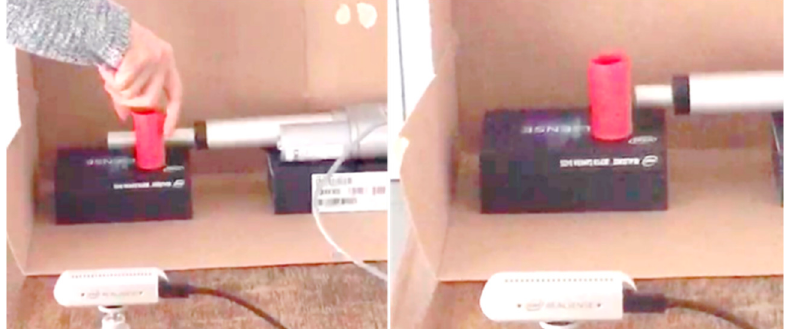
Figure 8. The actuator tracks the target object even if the target is placed behind the actuator (Left, Right).